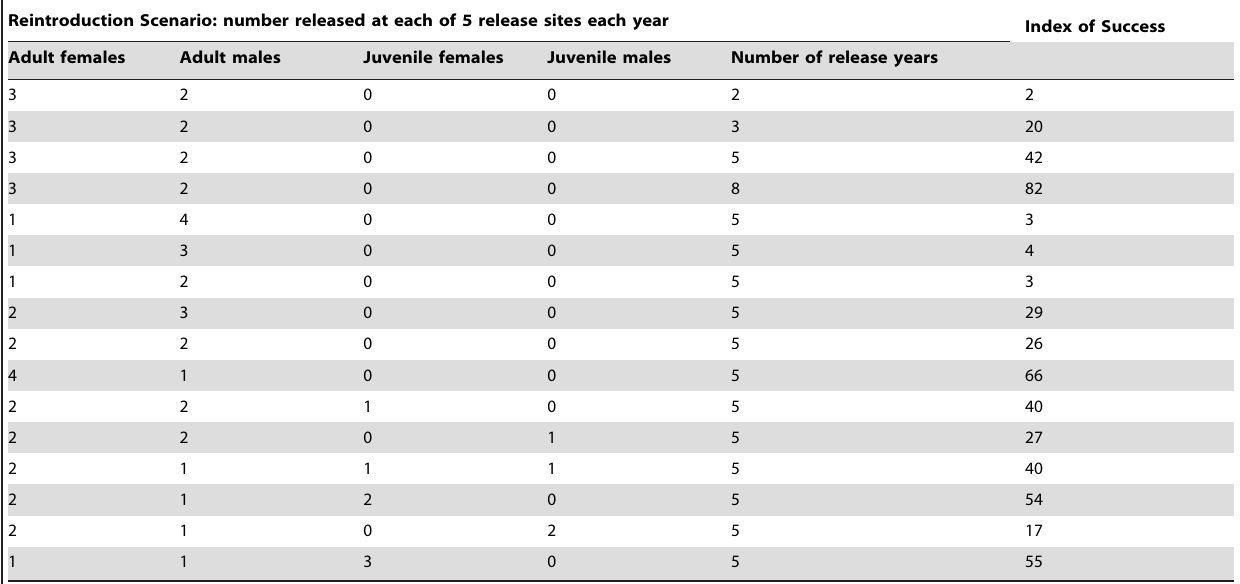
Table 4. Predicted index of successful reintroduction of fishers from 100 runs of VORTEX for differing founder population compositions.